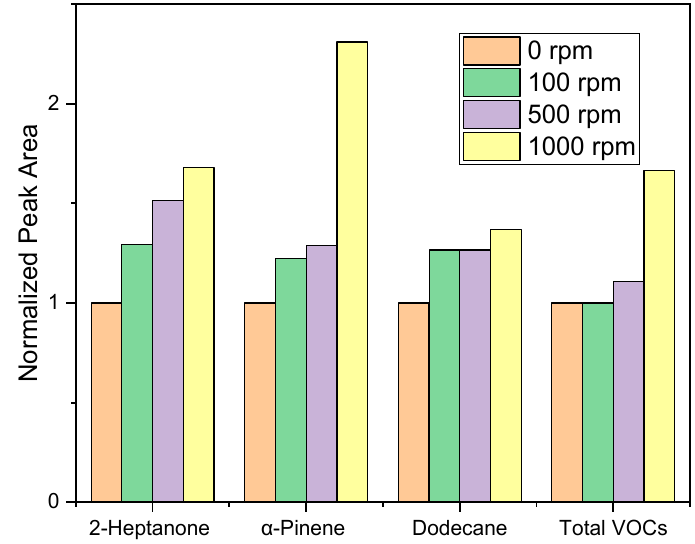
Figure 3. Evaluation of the extraction time for SPME Arrow.